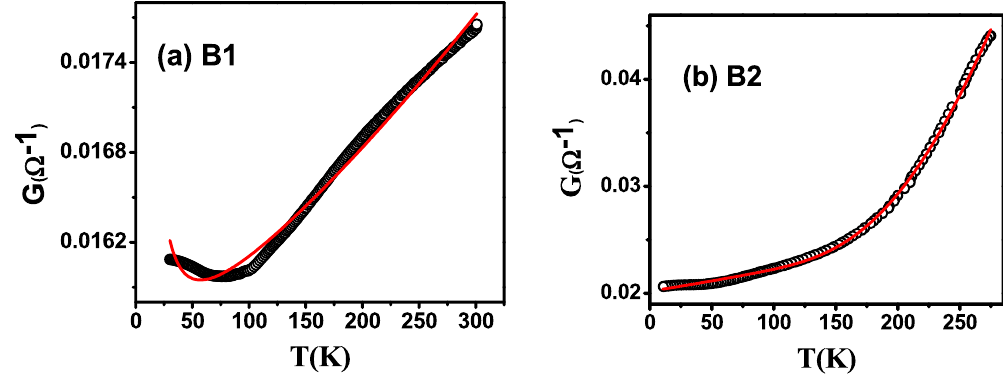
Figure 2. ( a ) Conductance data fitted to a non-linear curve given in Equation (3) for sample B1which includes both surface and bulk contribution to the conductance. (b ) Conductance as a function of temperature data fitted with the same expression for B2. The deviation in the low temperature regime in Fig. 2(a) is due to the onset of WAL which yields a logarithmic correction to conductance (Equation 2) which was not considered in this